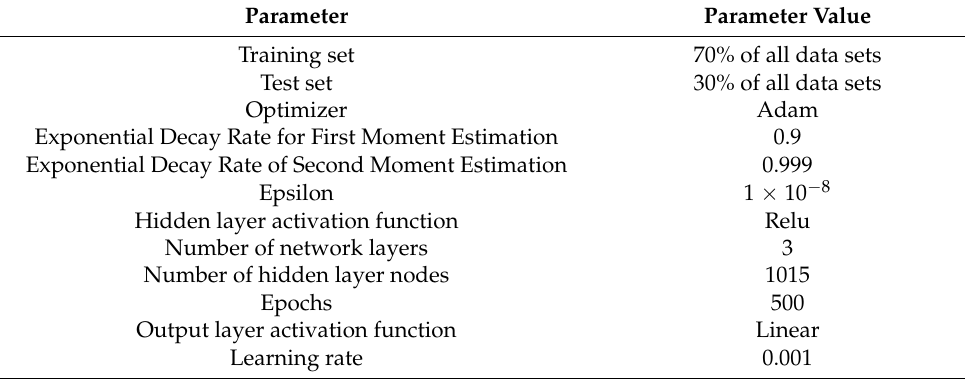
Table 3. BP model parameter.